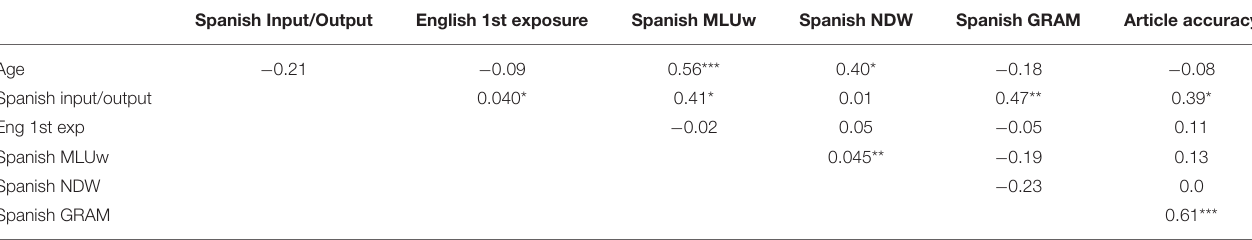
TABLE 3 | Pearson correlations between participant age, language history, and measures of language skills.